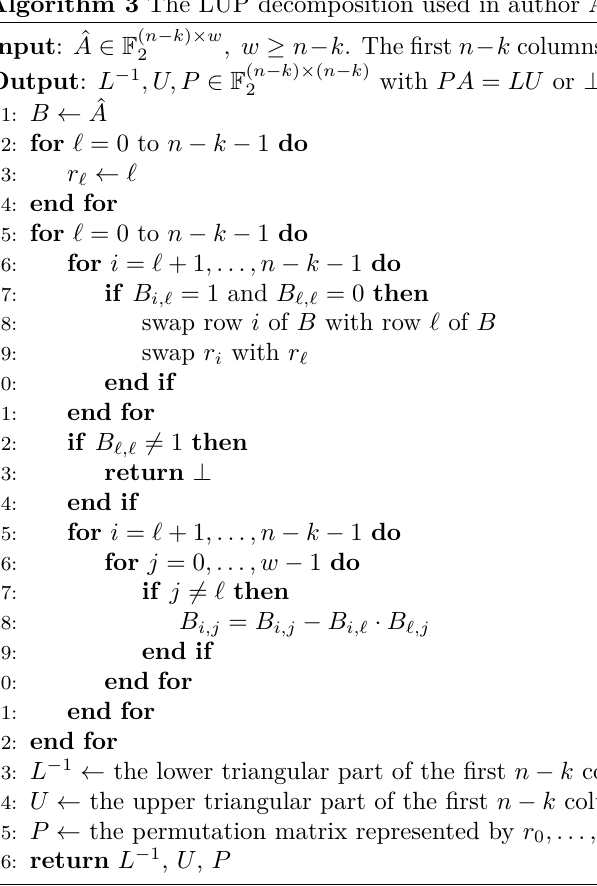
Algorithm 3 The LUP decomposition used in author A’s